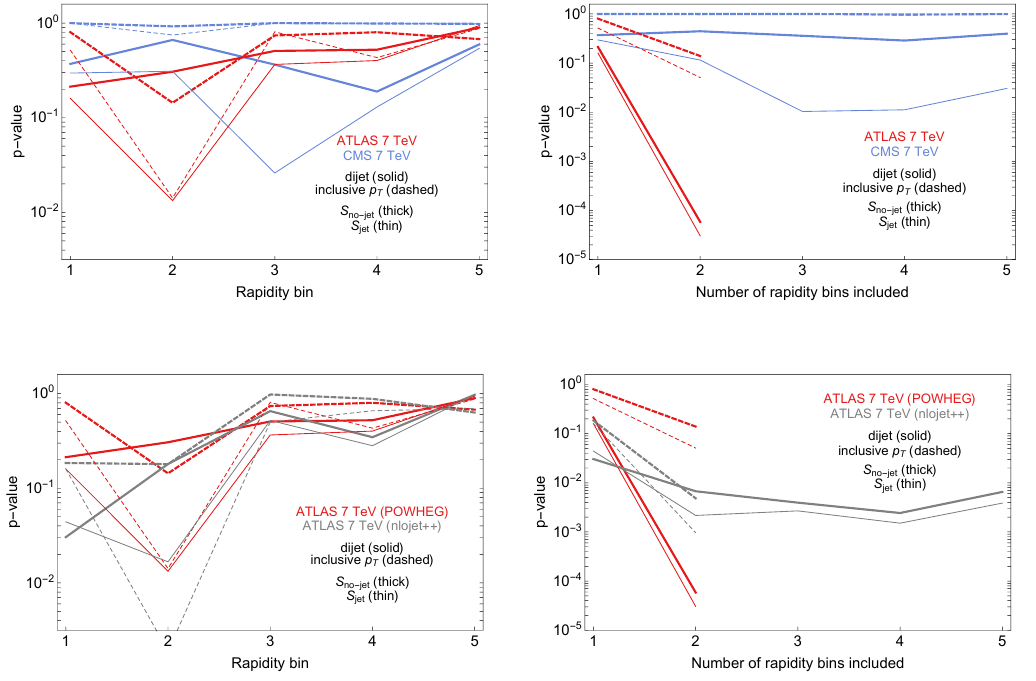
Figure 13 . p-values measuring the goodness of (cid:12)t of the SM prediction for the 7 TeV analyses. They are computed for individual y bins (left panels) and for their combination (right panels). The upper panels show the comparison between ATLAS and CMS for di(cid:11)erent choices of PDF set, using both dijet and inclusive jet data. The lower panels show only the ATLAS results in which the SM prediction is obtained with two di(cid:11)erent generators: either POWHEG , as above, or NLOJet++ . Points that are absent in the combination plots lie outside the range of the plot and correspond to very poor p-values, as explained in the